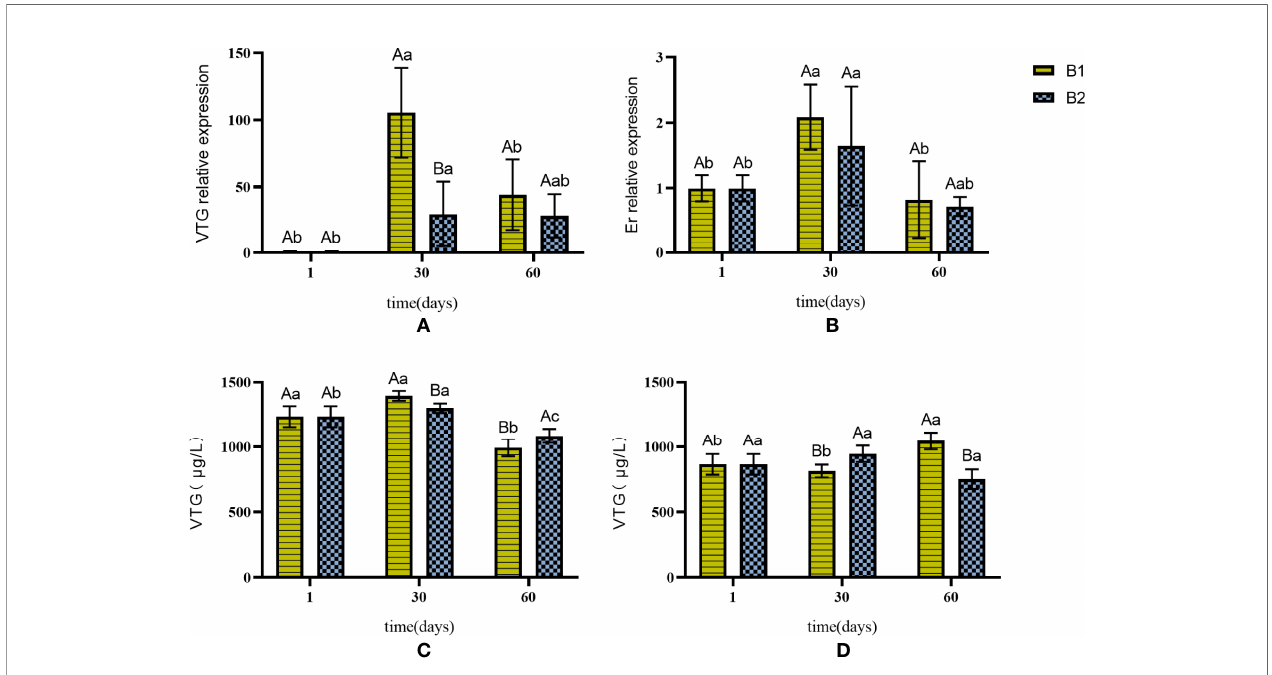
FIGURE 4 | The expression of VTG and Er genes in liver and the content of VTG in liver and serum in B1 and B2. (A) VTG gene expression in the liver. (B) Er gene expression in the liver. (C) changes in the content of VTG in the liver. (D) changes in the content of VTG in the serum. The capital letters marked in the chart indicate signi fi cant differences between the swimming group and the resting group ( p < 0.05). Lowercase letters indicate differences within the same group ( p < 0.05). VTG, vitellogenin; Er, estrogen